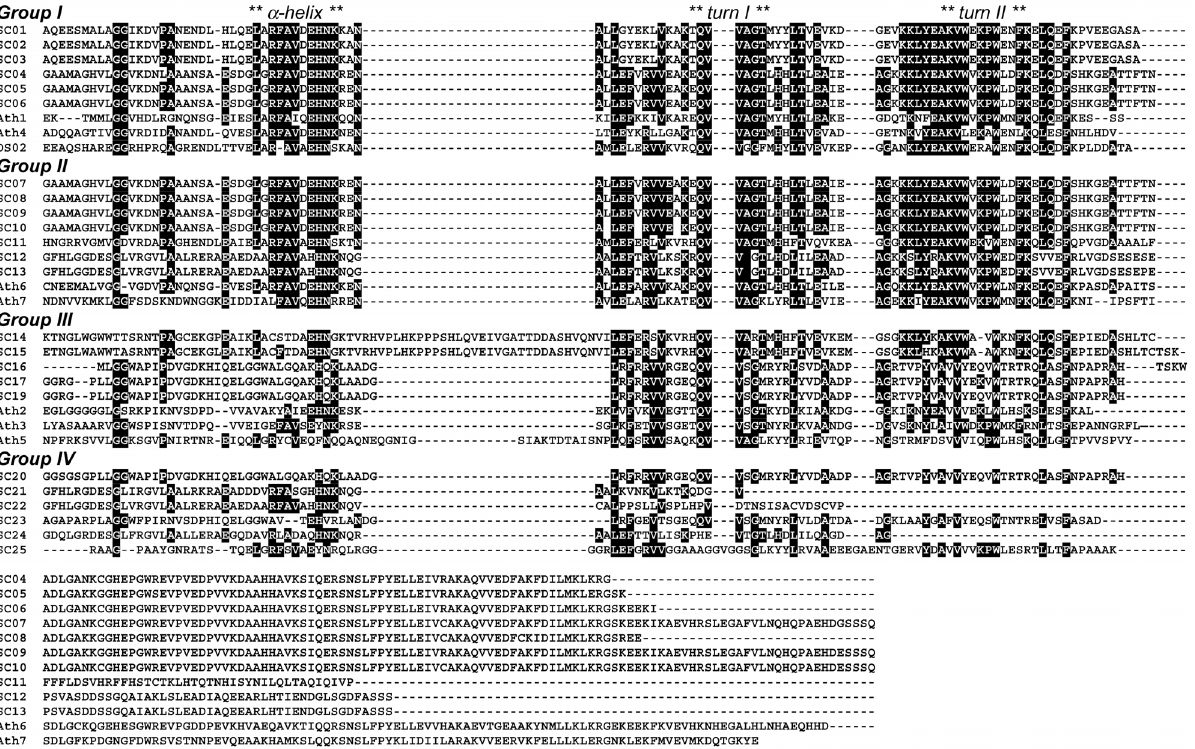
Figure 1 - Alignment of sugarcane phytocystatin clusters with seven A. thaliana phytocystatins (Ath1 to Ath7) and rice phytocystatin-II (OS 02). Align- ment was performed using the MAP algorithm. Phytocystatins were divided into four major groups according to different sequence characteristics. Re- gions corresponding to putative phytocystatin N-terminal alpha-helix and to beta-turns I and II are emphasized.